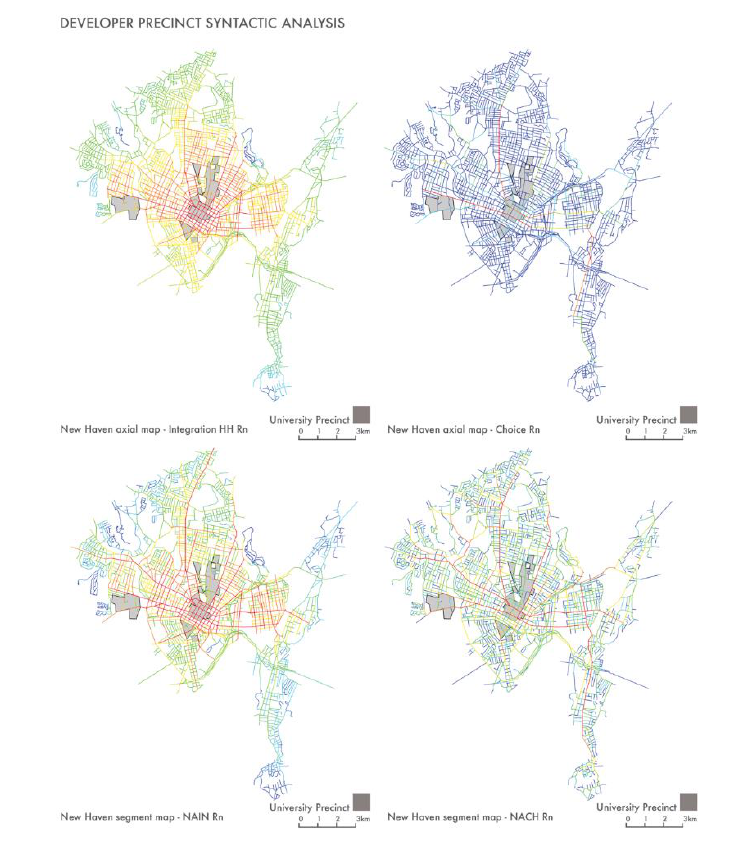
Figure 5 New Haven Axial and Segment Map. Yale University Campus